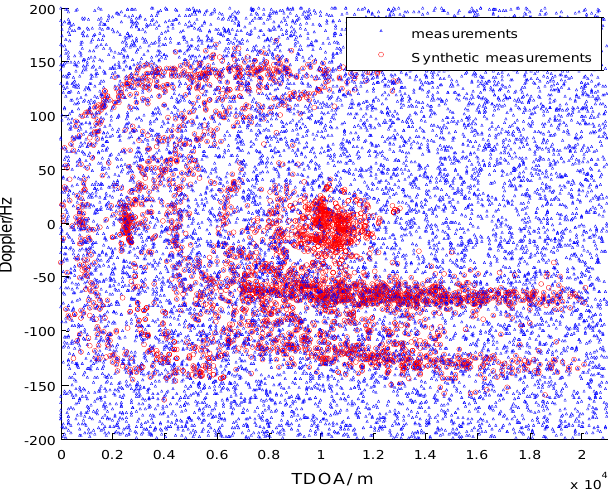
Figure 4. EKF probabilistic multi-hypothesis tracker (PMHTe) synthetic measurements with